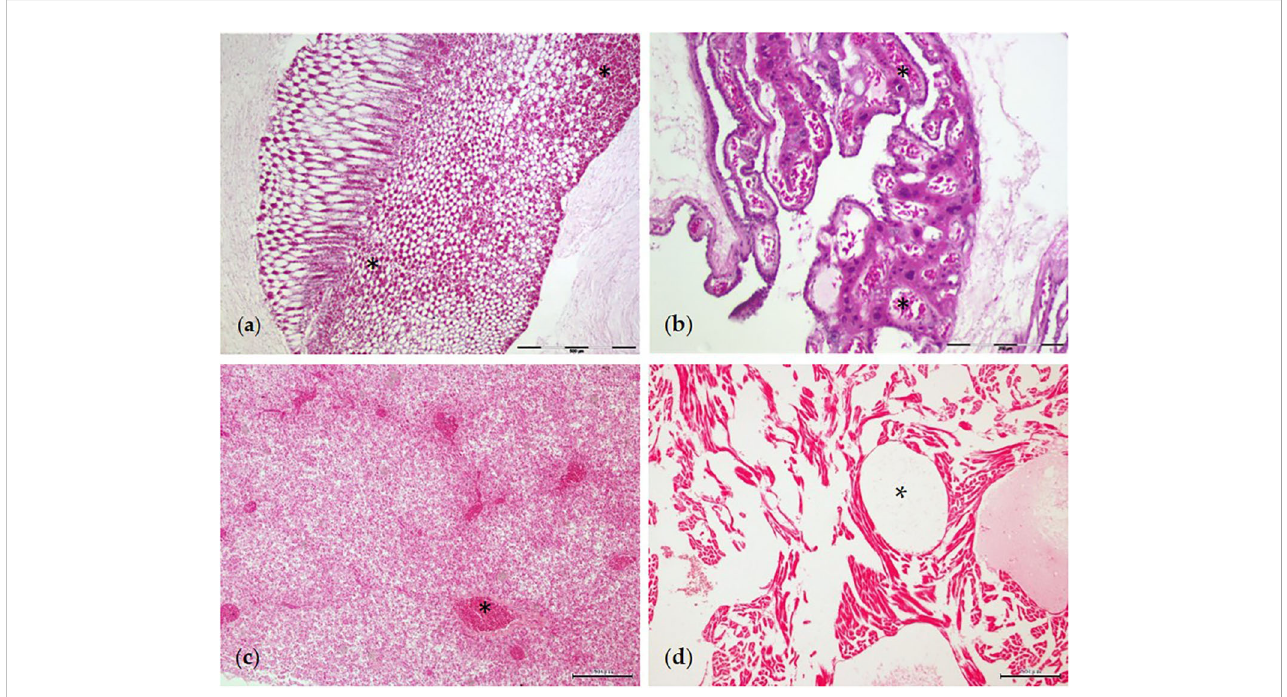
FIGURE 4 Microscopy fi ndings in fi shes from El Hierro volcano. Severe congestion (*) of the rete mirabile in a specimen of Balistes carolinensis ( A , H&E, bar=500µm) and Helicolenus dactylopterus ( B , H&E, bar=200µm). Liver congestion (*) in a specimen of Hoplostethus mediterraneus ( C , H&E, bar=200µm). Gas bubble (*) in the heart ventricle in a specimen of Grammicolepis brachiusculus ( D , H&E, bar=200µm).